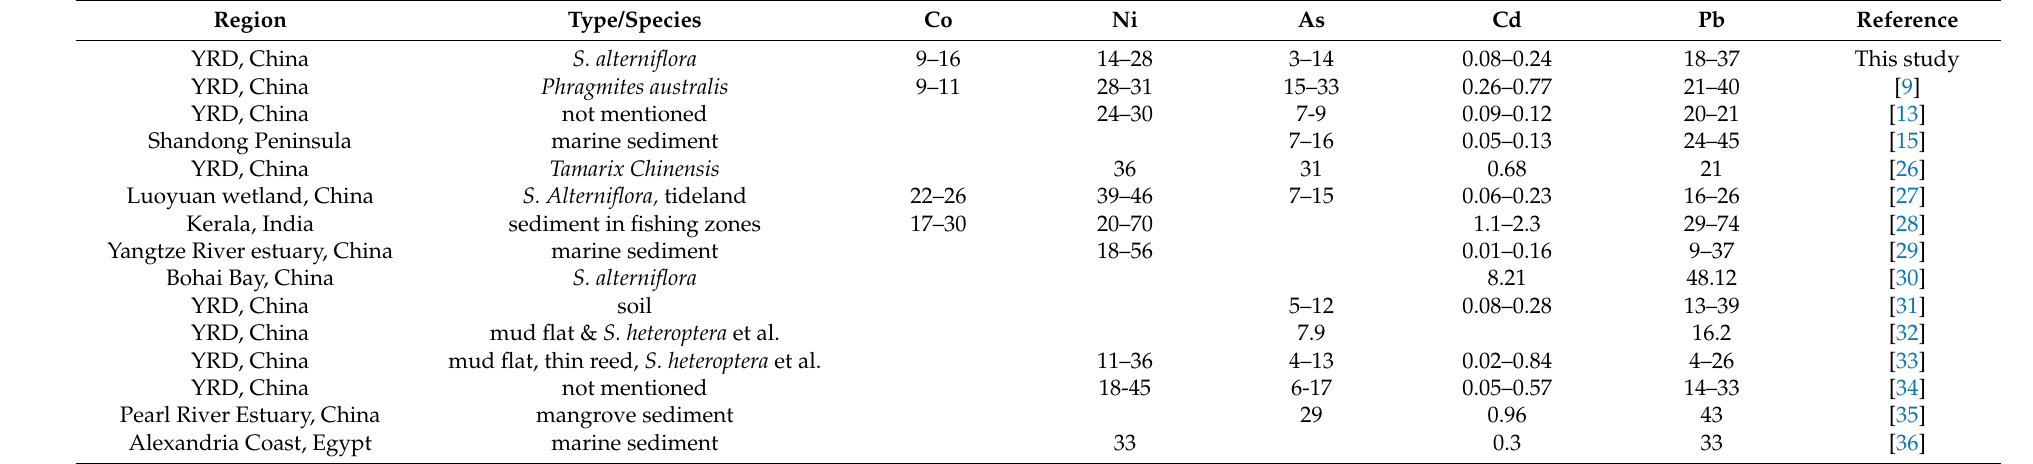
Table 2. Heavy metal mass fractions in sediments from the Yellow River Delta and some other regions (mg/kg).